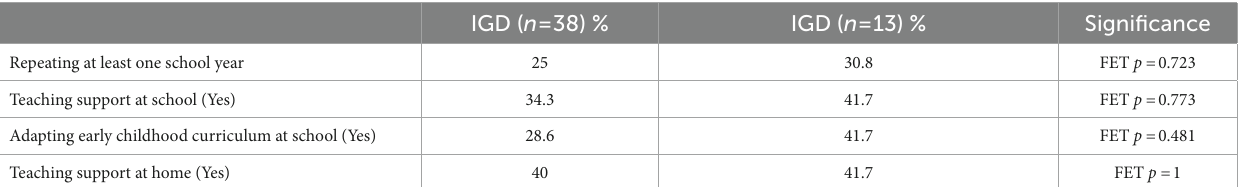
TABLE 6 Academic impact of IGD.